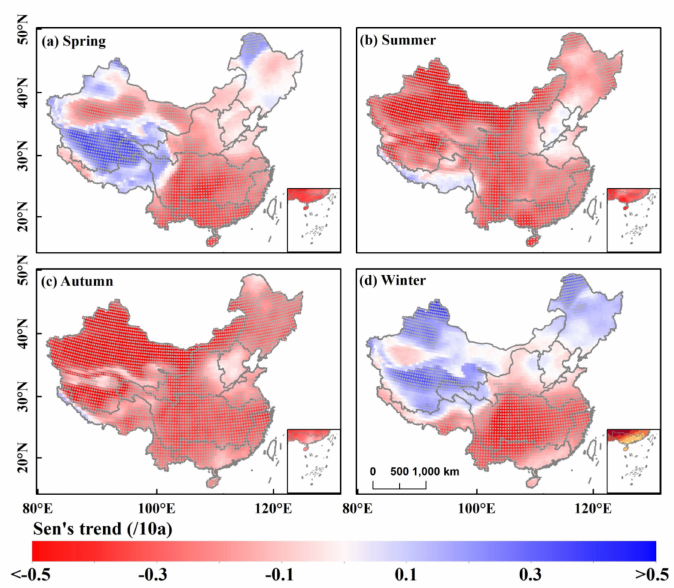
Figure 7. Spatial patterns of the SPEI03-based drought trend in ( a ) spring, ( b ) summer, ( c ) autumn, and ( d ) winter across China during 1961–2014, calculated using Equation (7). Gray dots indicate significance at a 99% confidence level using the Mann–Kendall method. Spring was from